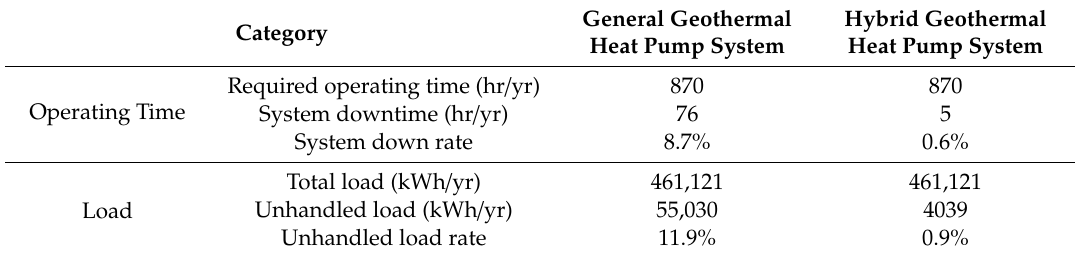
Table 8. Performance comparison of geothermal system and hybrid geothermal heat pump system.